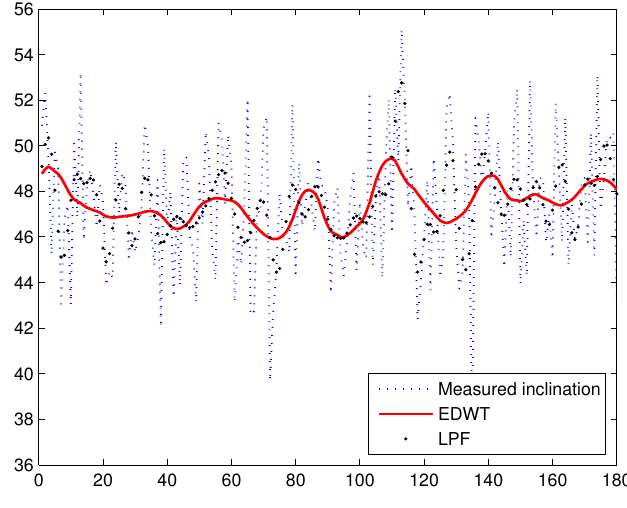
Figure 10. Comparison of inclination angles before and after filtering. The comparison of tool face angle measurements and filtered tool face angle plots are given in Figure 11. The tool face angle using EDWT is around 317 ◦ with accuracy between ± 5 ◦ .